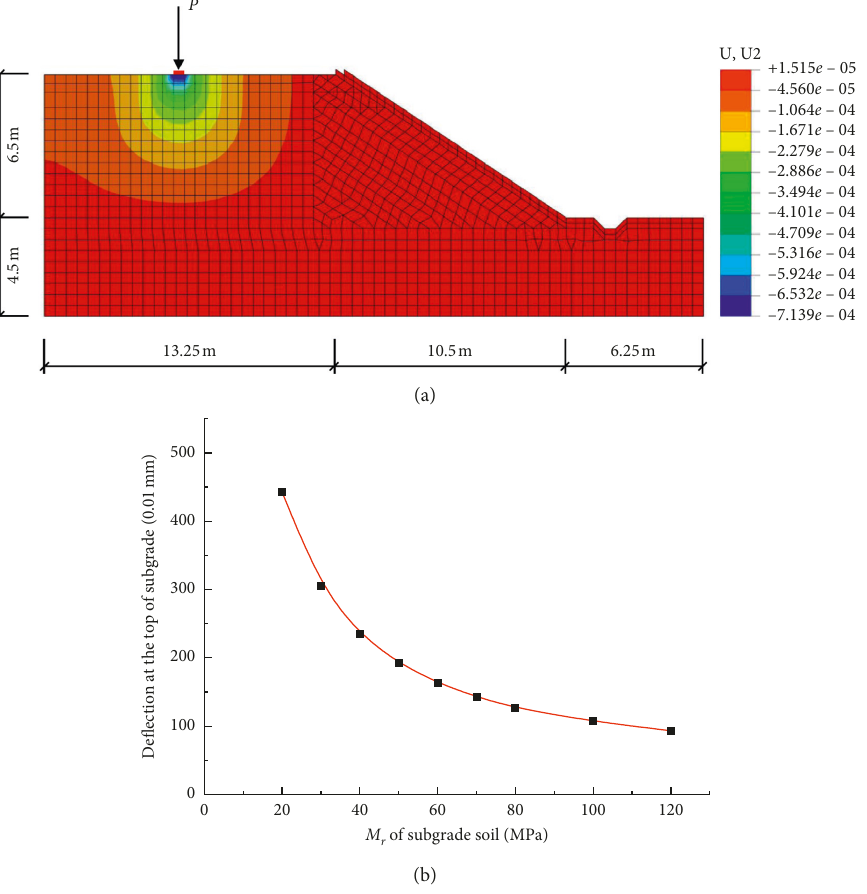
Figure 2: Deflection results of subgrade under dynamic loading. (a) Calculation deflection in the FEM. (b) Relationship between the resilient modulus and the deflection of